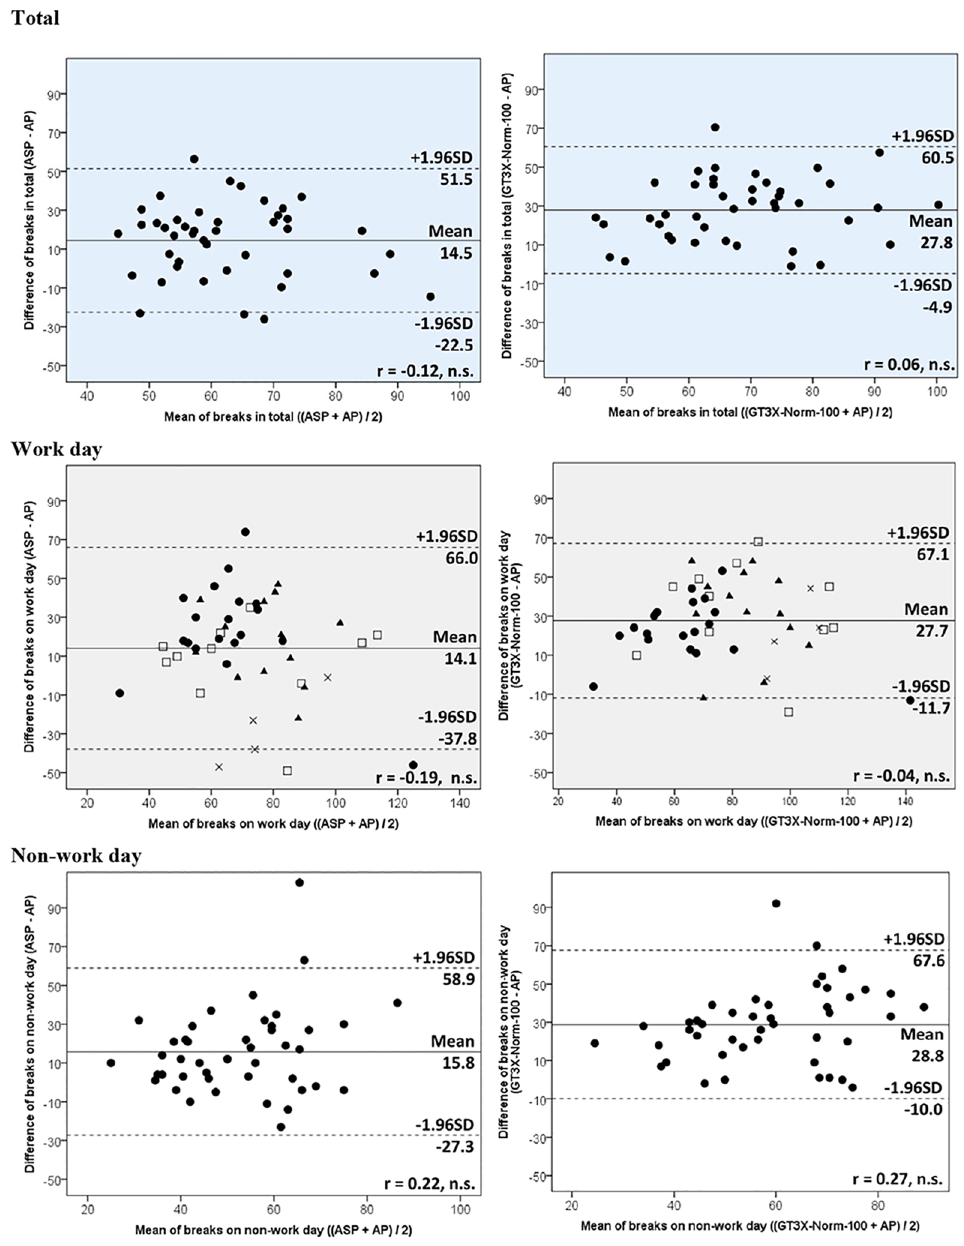
Fig 2. Bland-Altman plots of breaks between monitors. The shape of the relationshipson work days represent participants’ usual task at work; ● - sitting task, ▲ - standing task, □ - walkingtask, × - physicaltask. Solid horizontal lines represent mean difference and dashedlines represent levels of